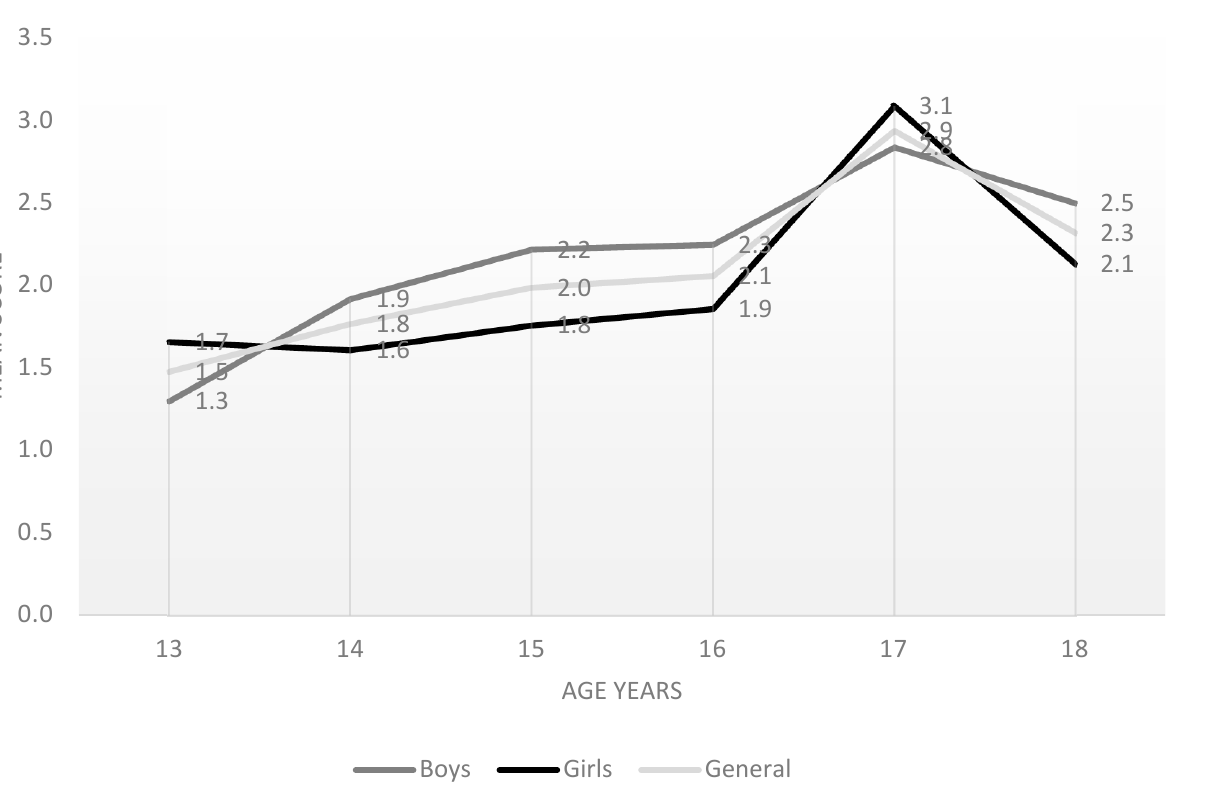
Table 6. Backward stepwise binary logistic regression.